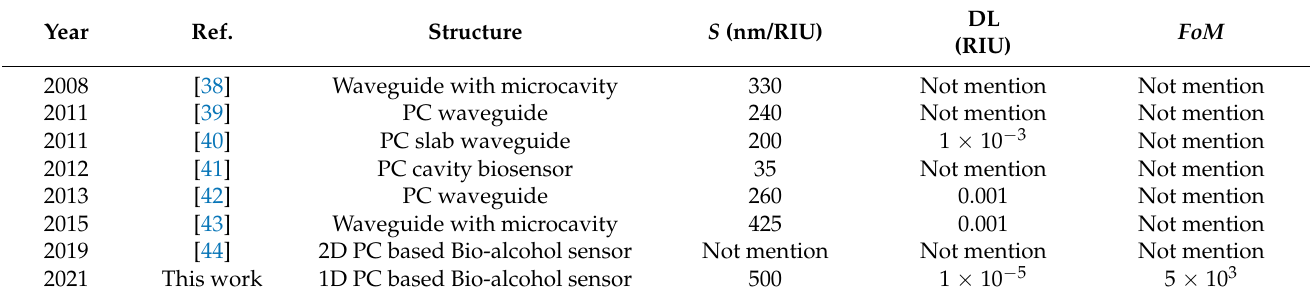
Table 7. Comparison between the present sensor and previously reported